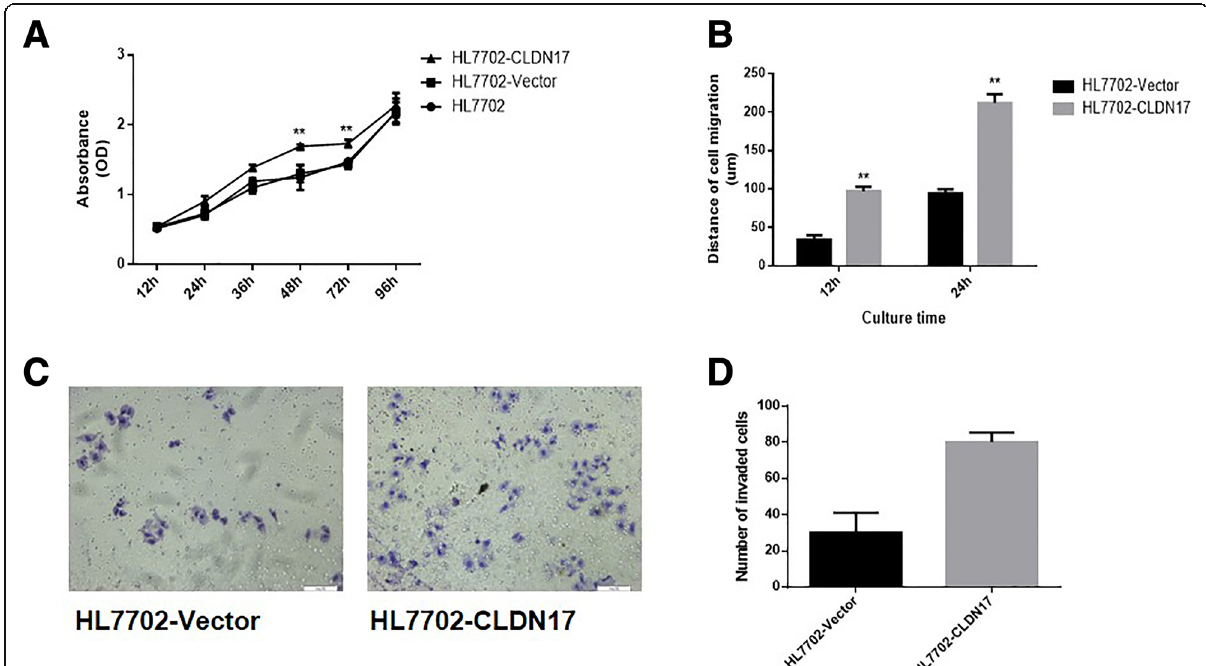
Fig. 3 The impact of CLDN17 on the proliferation and migration ability of cells in vitro . a A growth curve for the HL7702 cell line was generated by the CCK -8 method; ( b ) A wound healing assay was utilized to detect the migration ability of the HL7702 cell line in vitro; ( c ) The Transwell chamber method was utilized to detect the invasive ability of the HL7702 cell line in vitro; ( d ) The corresponding statistical analysis of invaded cells. Note: * represents P < 0.05 and ** represents P < 0.01 compared with the empty vector groups